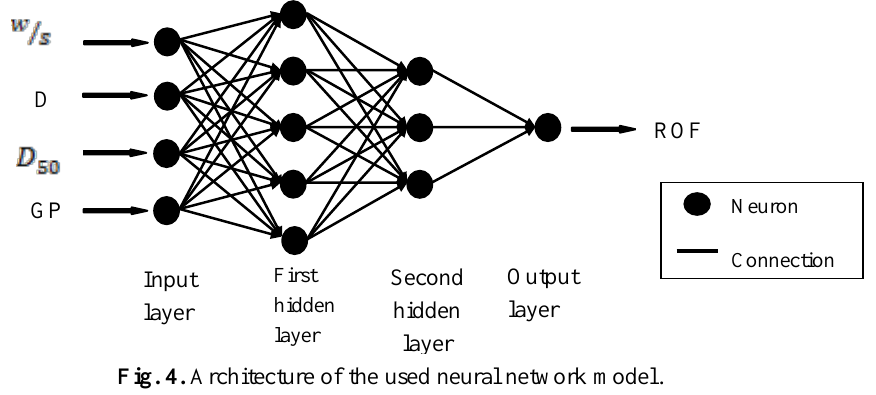
Fig. 4. Architecture of the used neural network model.